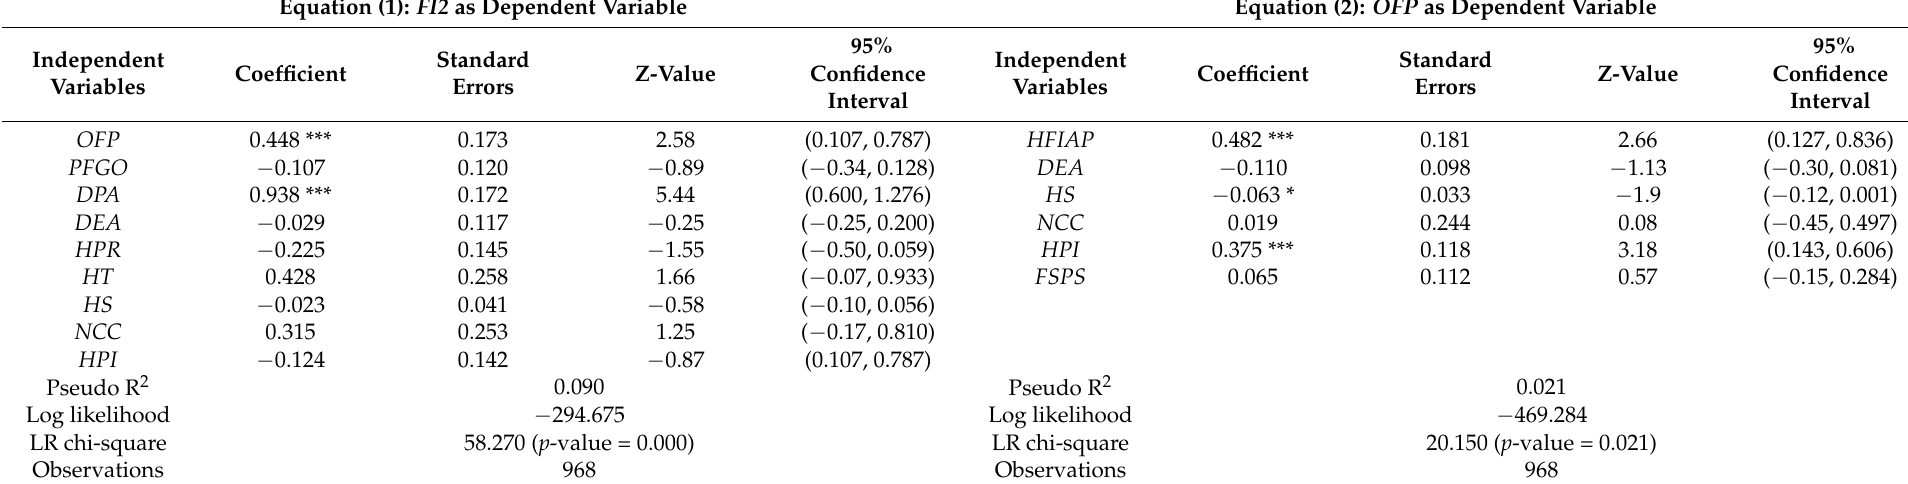
Table 9. Results of robustness tests of model